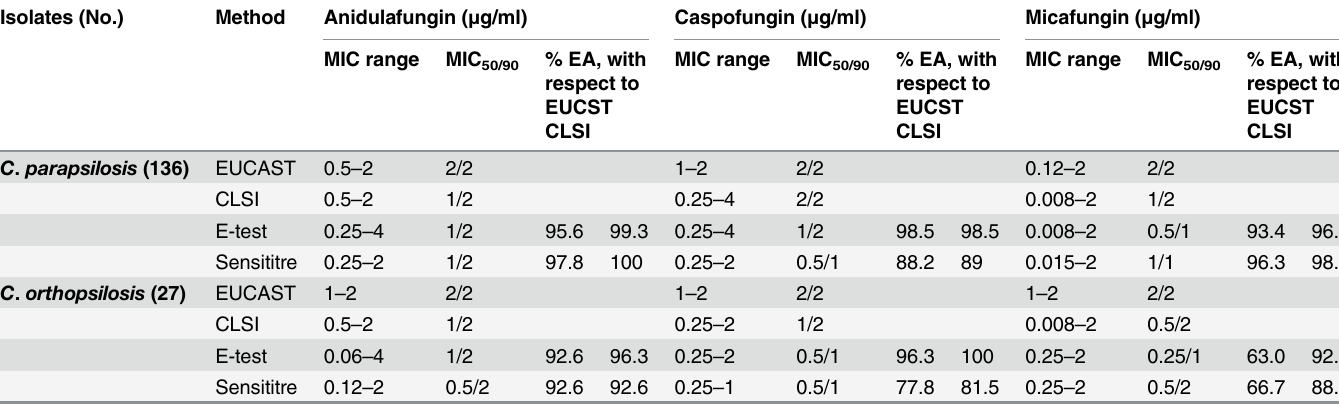
Table 2. MICs and EAs of the E-test and Sensititre methods compared with those of the CLSI and EUCAST methods. Isolates